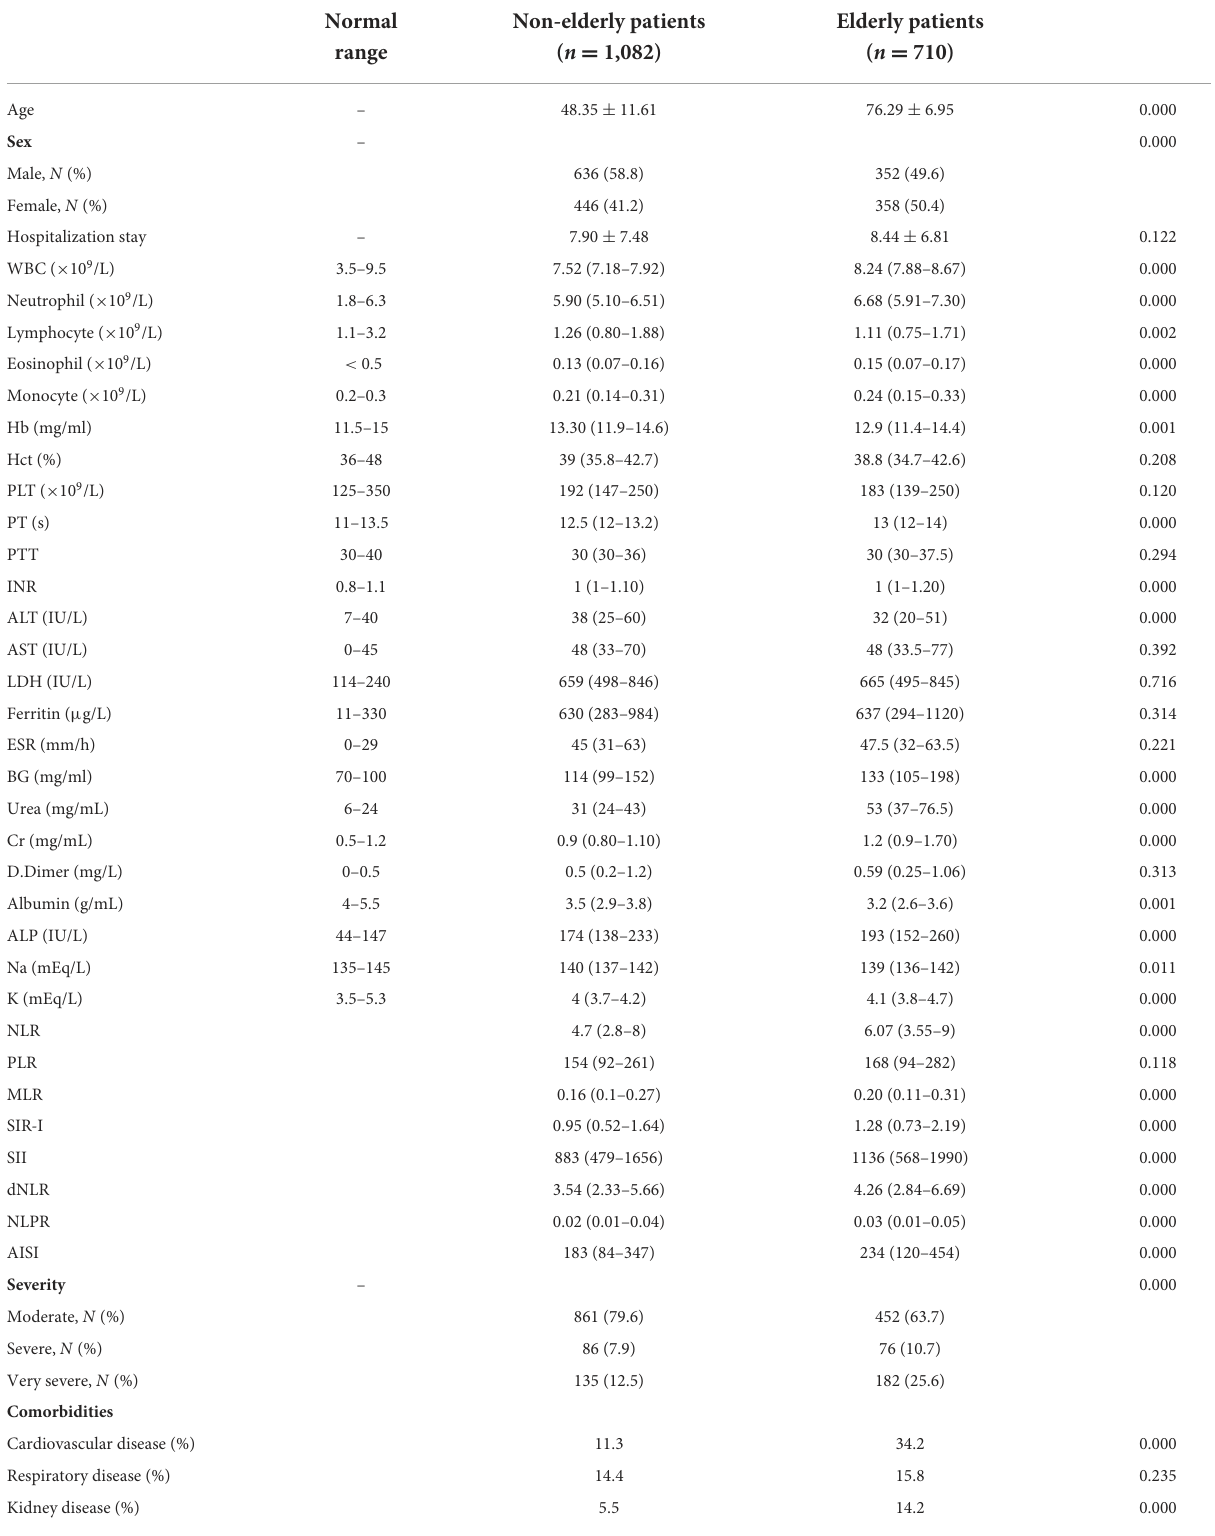
TABLE 1 Demographic, hematological, and blood cell count-derived inflammation indexes of non-elderly and elderly